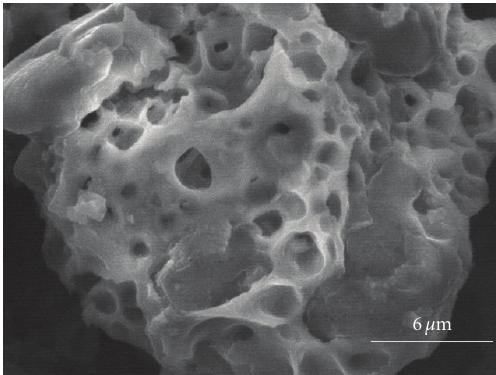
Figure 2: SEM image of the red-emitting porous powder ( x = 10 . 0 at % Eu) produced by PACS performed at